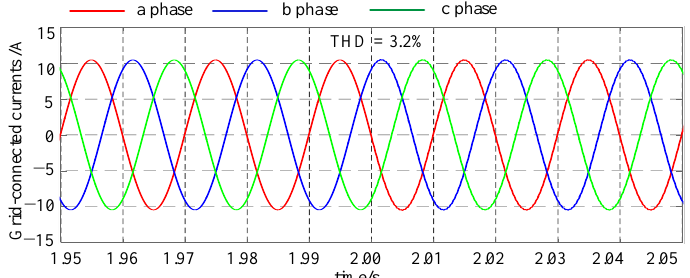
Figure 19. Current waveform under different parameters of the capacitor current regulator ( K p = 0.1, K i = 5, and K ic = 20).